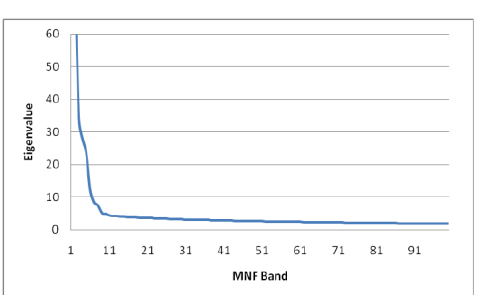
Fig. 6: MNF transform bands (a) MNF-Band2 (b) MNF- Band-7 and (c) MNF-Band-10.